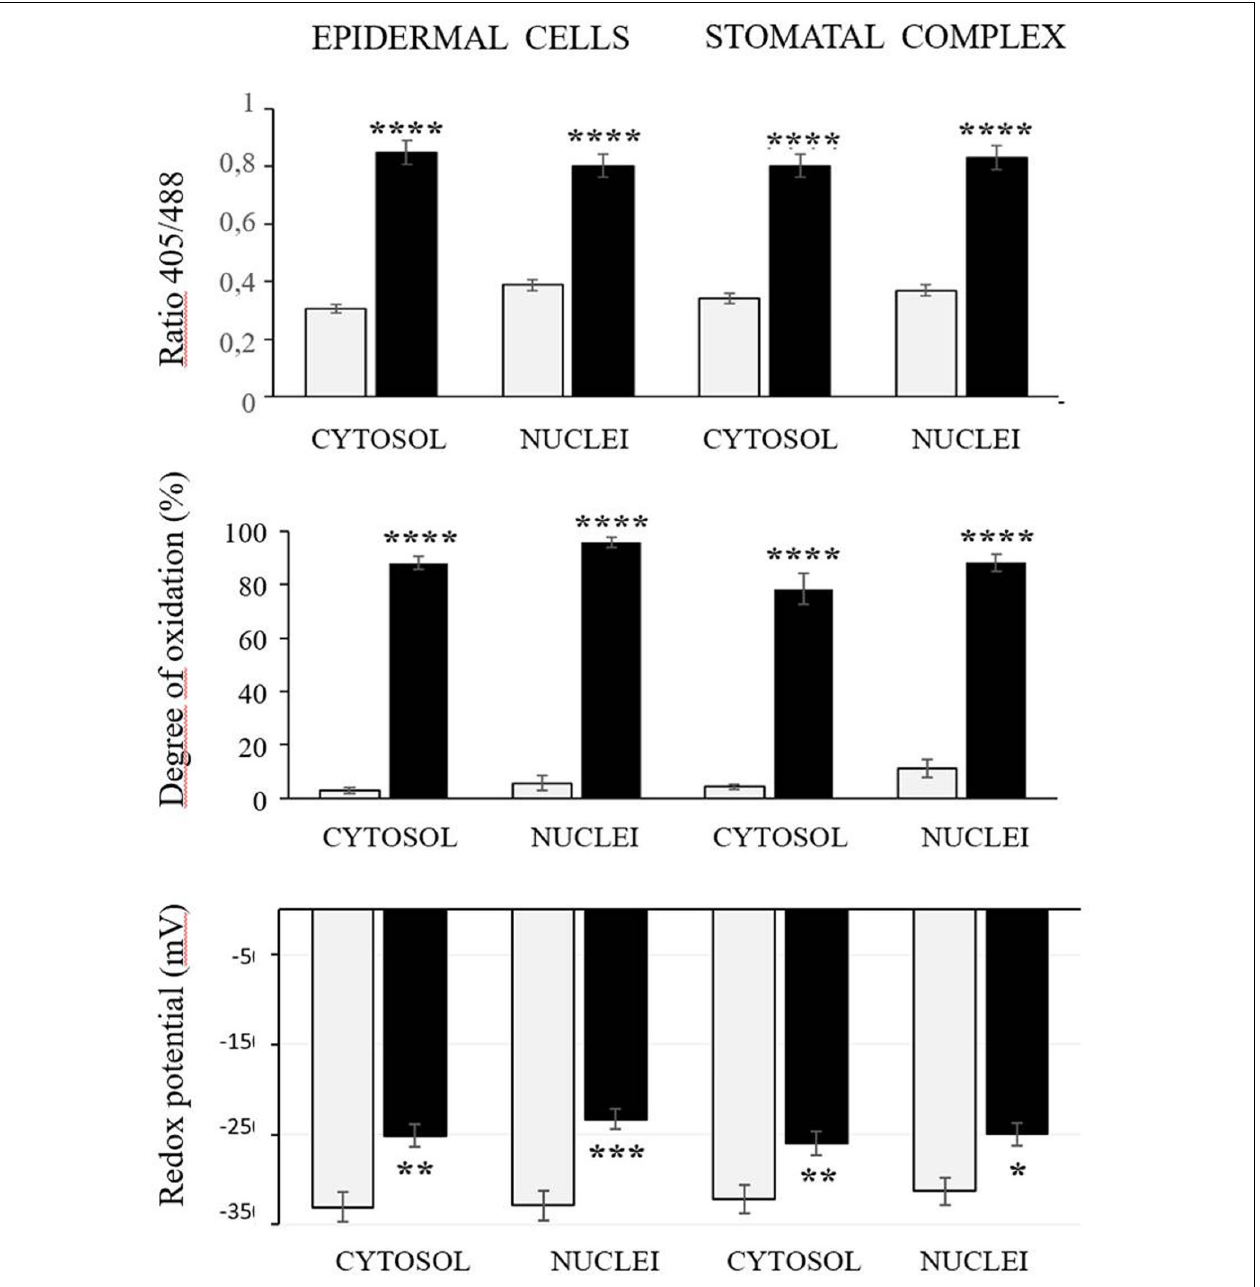
FIGURE 5 | The 405/488 ratios, the degree of oxidation, and the glutathione redox potential in the cytosol and nuclei of the epidermal and stomatal guard cells of the control (white bars) and heat treated (black bars) seedlings. Asterisks indicate significant differences between control and heat-stressed plants according to the Student’s t -test (* p < 0.05; ** p < 0.01; *** p < 0.001; and **** p <